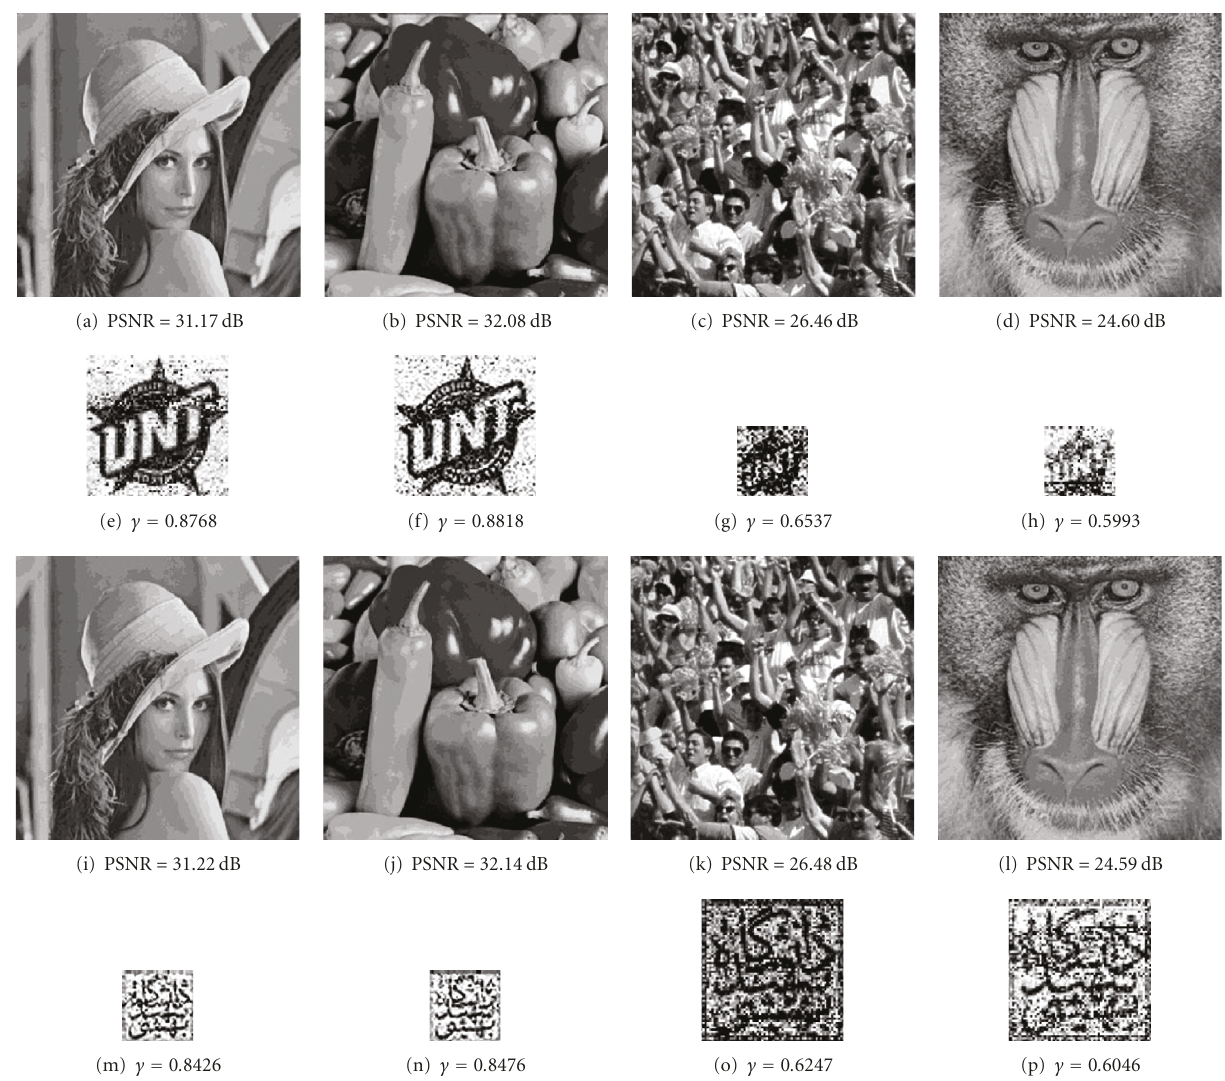
Figure 22: (a) and (b) Lena and Peppers watermarked images with 256 × 256 watermark image as shown in Figure 11(b) after applying Median filter with window size 5 × 5, (e) and (f) the extracted watermarks with size 256 × 256 from (a) and (b), respectively. (c) and (d) Crowd and Baboon watermarked images with 128 × 128 watermark image as shown in Figure 11(b) after appling Median filter, (g) and (h) the extracted watermarks with size 128 × 128 from (c) and (d), respectively. (i) and (j) Lena and Peppers watermarked images with 128 × 128 watermark image as shown in Figure 11(d) after appling Median filter, (m) and (n) the extracted watermarks with size 128 × 128 from (i) and (j), respectively. (k) and (l) Crowd and Baboon watermarked images with 256 × 256 watermark image as shown in Figure 11(d) after appling Median filter, (o) and (p) the extracted watermarks with size 256 × 256 from (k) and (l), respectively.